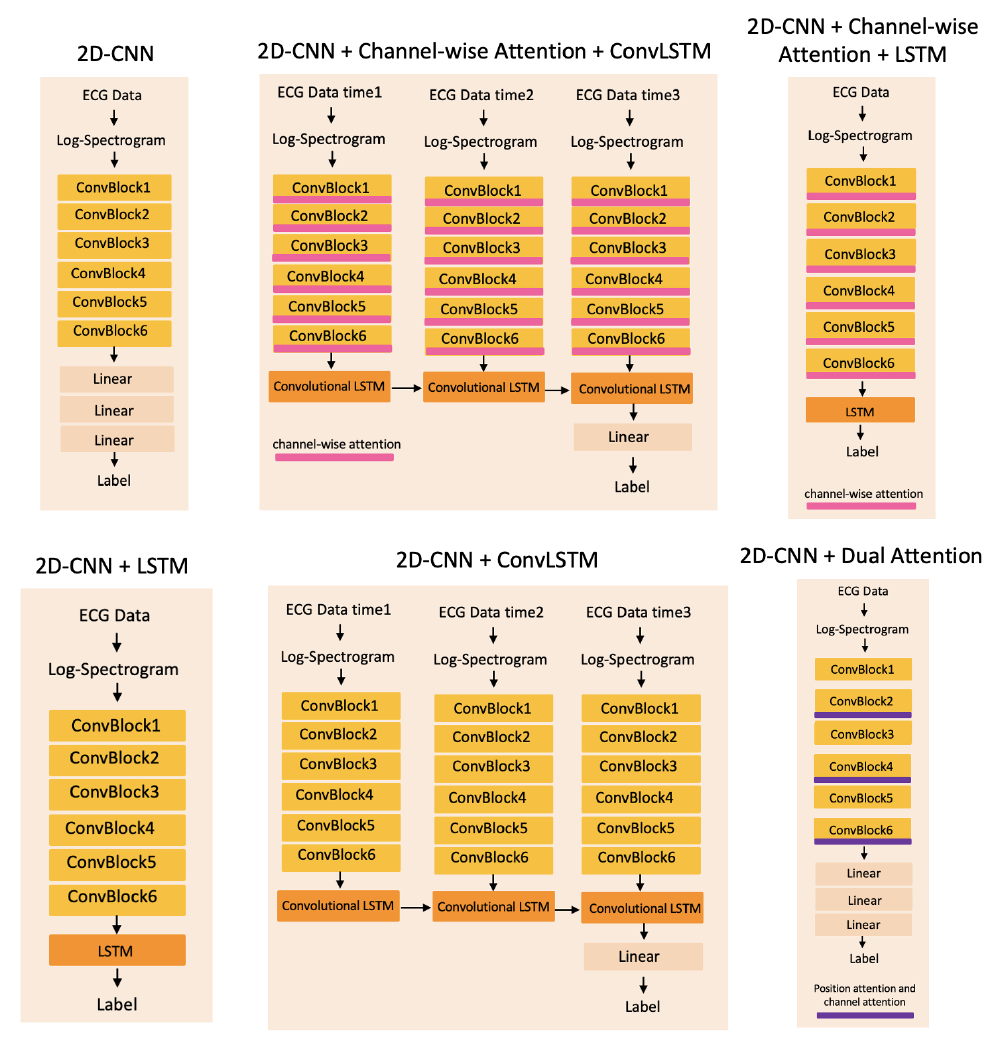
Figure 5. The architecture of deep learning methods which are used to compare with the proposed method. The methods from left to right, top: 2D-CNN; 2D-CNN + Channel-wise Attention + ConvLSTM; 2D-CNN + Channel-wise Attention + LSTM; bottom: 2D-CNN + LSTM; 2D-CNN + ConvLSTM; 2D-CNN + Dual